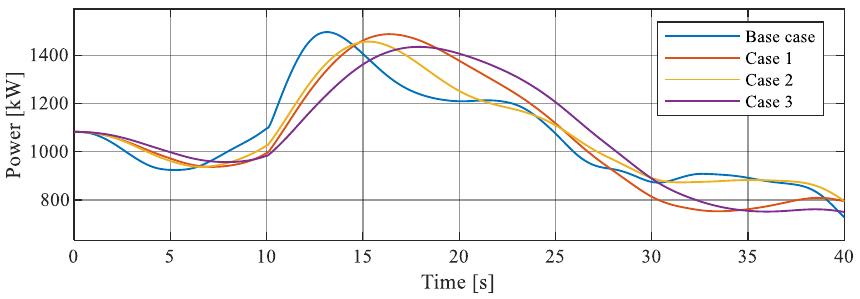
Figure 21. Power generated by the thermal power plant under variable wind speed conditions.